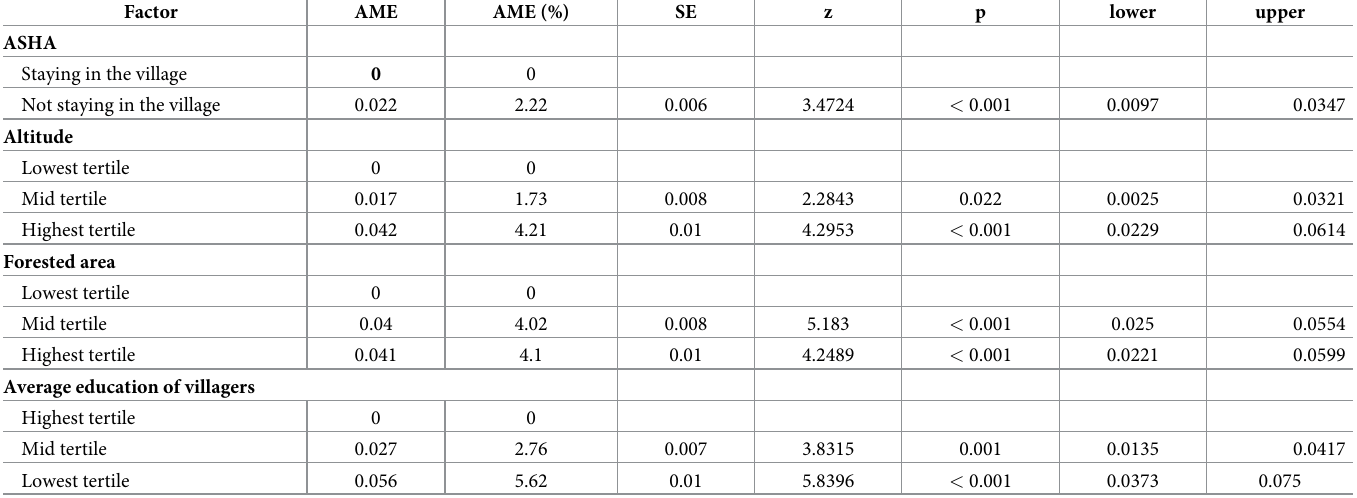
Table 4. Average marginal